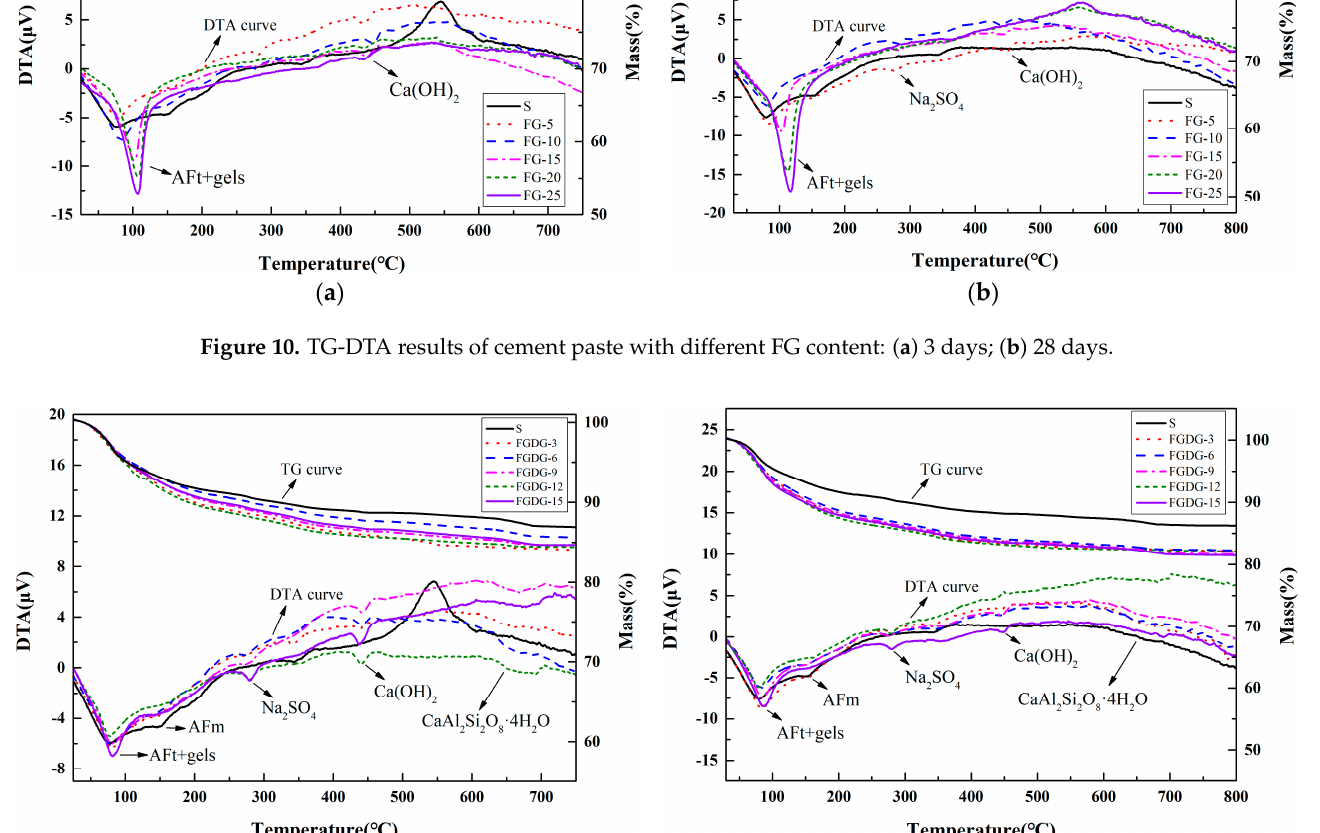
Crystals 2021 , 11 , 1475 10 of 18